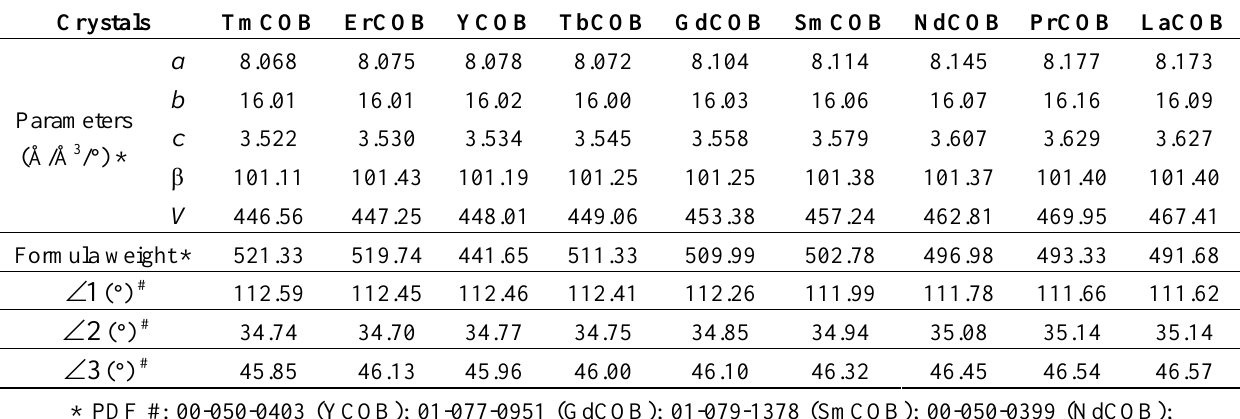
Table 2. Unit cell parameters and interfacial angles for different ReCOB crystals in space group C